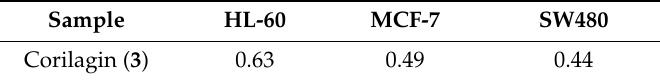
Table 3. Selectivity index of compound 3